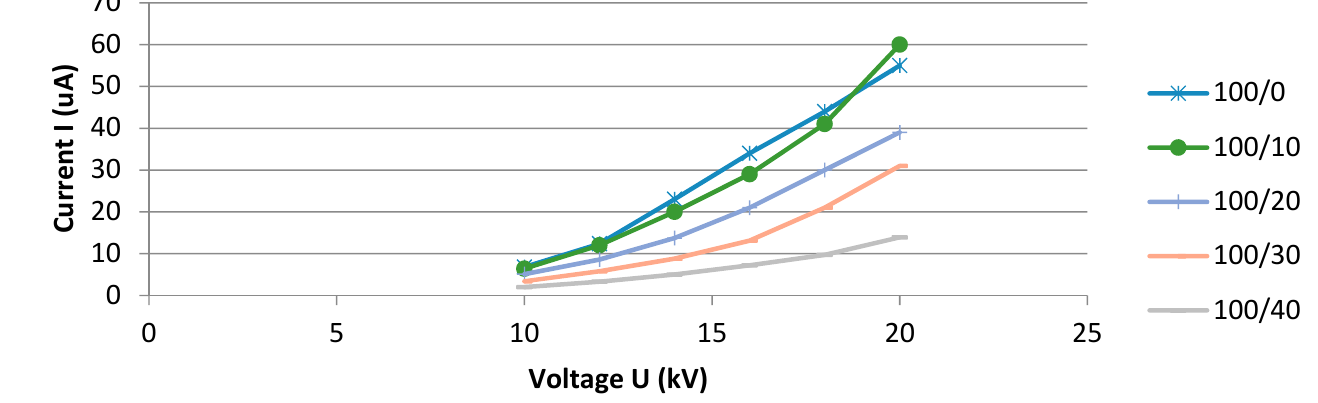
Figure 8. Measured V-A characteristic of the airflow generator with a = 100 mm for five different electrode gaps g .